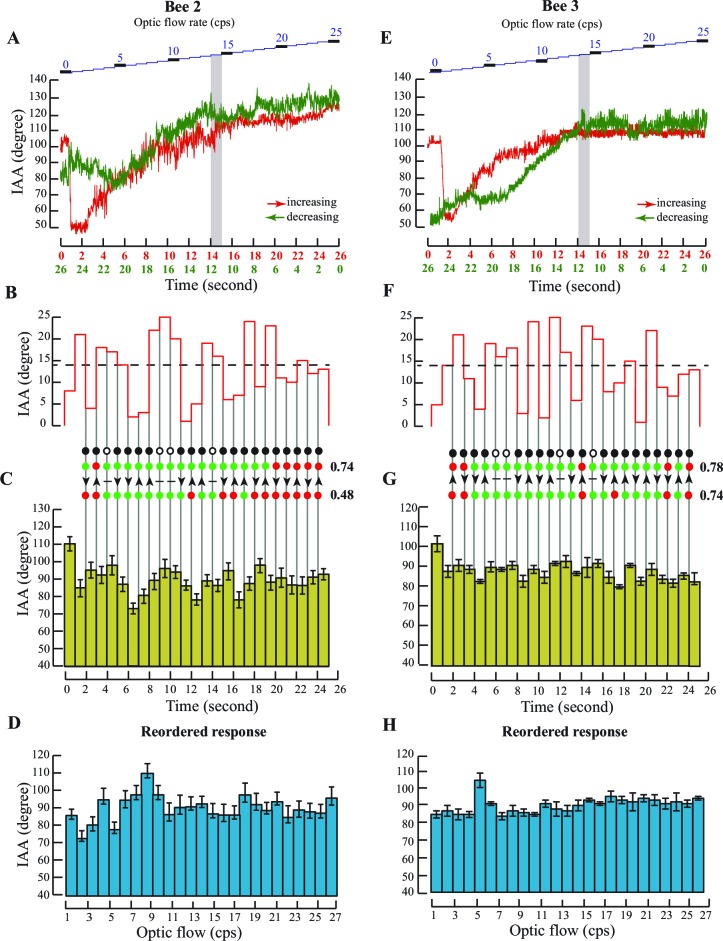
Antennal responses to changing optic flow rates.Data for two additional individuals. Figure 2—figure supplement 1A–D show data from one individual and Figure 2—figure supplement 1E–H for a second individual. (A and E) IAA responses of linearly changing optic flow rates in tethered bees. Data from two bees showing the IAA response to linearly ascending (red plot) and linearly descending (green plot) temporal frequencies between 0 and 25 cps. The step changes in optic flow rates have been shown in blue at the top. In both cases, the IAA response to changing rates of optic flow saturates after 14 cps. (B and F) Optic flow stimulus provided to the tethered bees. Each optic flow stimulus lasted for 1 s. Black dotted line indicates the threshold after which the response to changing optic flow saturates (threshold calculated from Figure 2—figure supplement 1A and E). Grey lines indicate the transition from one value of temporal frequency to the next. (C and G) IAA responses of the bees to randomly changing optic flow rates between 0 and 25 cps. Olive green bar graphs show the actual response of the bees to the stimulus pattern shown in Figure 2C and Figure 2—figure supplement 1H respectively. The threshold in both cases is 14 cps. Predictions and scores are described in Figure 2C,D. The score for predicting motion was 17/23=0.74 (74% accuracy) and the score for prediction change in direction of antennal motion was 11/23=0.48 (48% accuracy, Figure 2—figure supplement 1C) and 18/23 = 0.78 (78% accuracy) and 17/23=0.74 (74% accuracy,Figure 2—figure supplement 1G). (D and H) IAA responses to randomized optic flows between 0 and 25 cps in two bees. IAA responses of the bee (blue) are reordered and represented against optic flow. Bar graphs show the mean and standard deviation of the IAA response to each optic flow rate value. The first optic flow experienced by the bee in Figure 2—figure supplement 1B was 8 cps and in Figure 2—figure supplement 1F was 5 cps. In both these cases, the IAA at the first optic flow rate stands out from the rest of the dataset. No significant trend emerges from the IAA response of the bee to randomised optic flow rates.